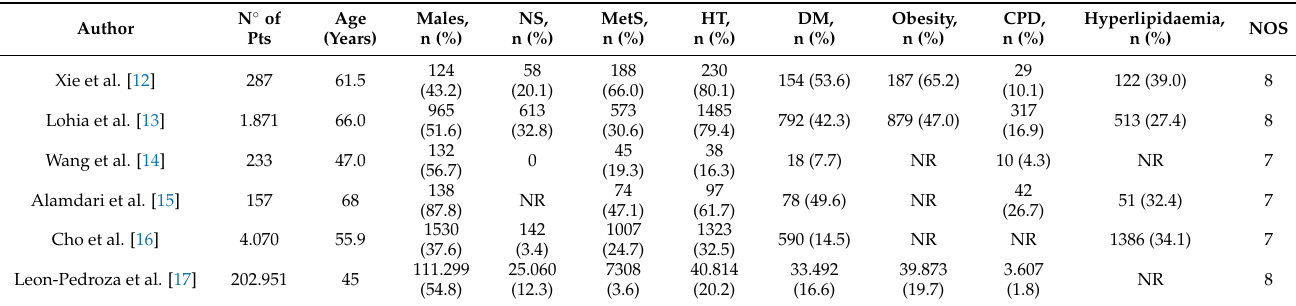
Table 2. General characteristics of the population enrolled. NS: Non-survivors; MetS: Metabolic syndrome; HT: Arterial hypertension; DM: Diabetes Mellitus; CPD: Chronic obstructive pulmonary disease; NOS: Newcastle-Ottawa quality assessment scale.